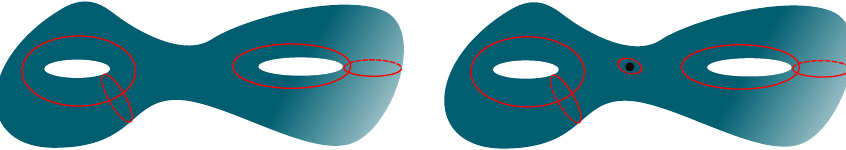
Figure 4 . On the left is a genus-two surface with four cycles shown in red. Each inde- pendent cycle gets an OSp (1 | 2) holonomy group element, with a single relation between them: ( A − 1 A − 1 B 1 )( A 2 B − 1 A − 1 B 2 ) = 1 . If each cycle is in the hyperbolic conjugacy class, then the 1 B 1 1 2 2 surface is smooth. On the right is a genus-two surface with five cycles, one of which is a conical defect shown as a black dot. This surface is not smooth since one of the cycles has an elliptic holon- omy matrix associated to it. It has to be excluded from the gravity path integral configurations, but is present in the OSp (1 | 2) BF